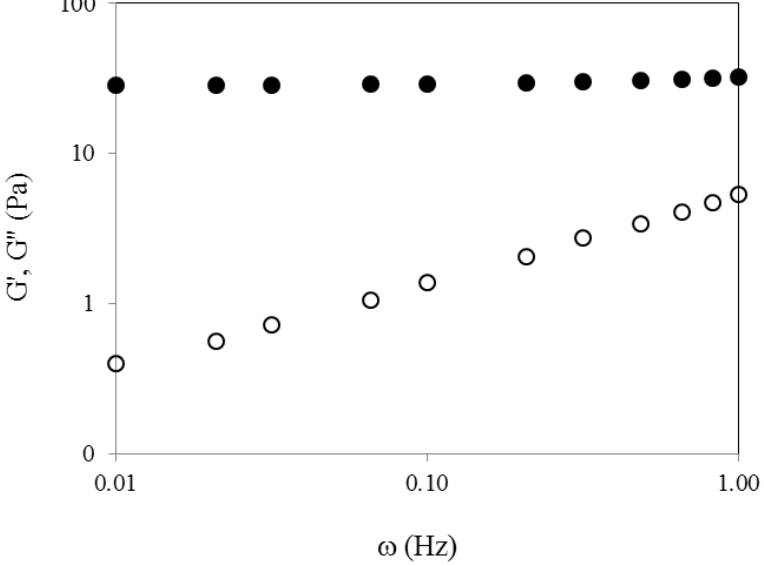
Figure 4. Mechanical spectrum of WEAX gel at 2% (w/v). G ′ ( ○ ), G ′′ ( ● ). Measurements at 25 °C, 1 Hz and 10% strain.